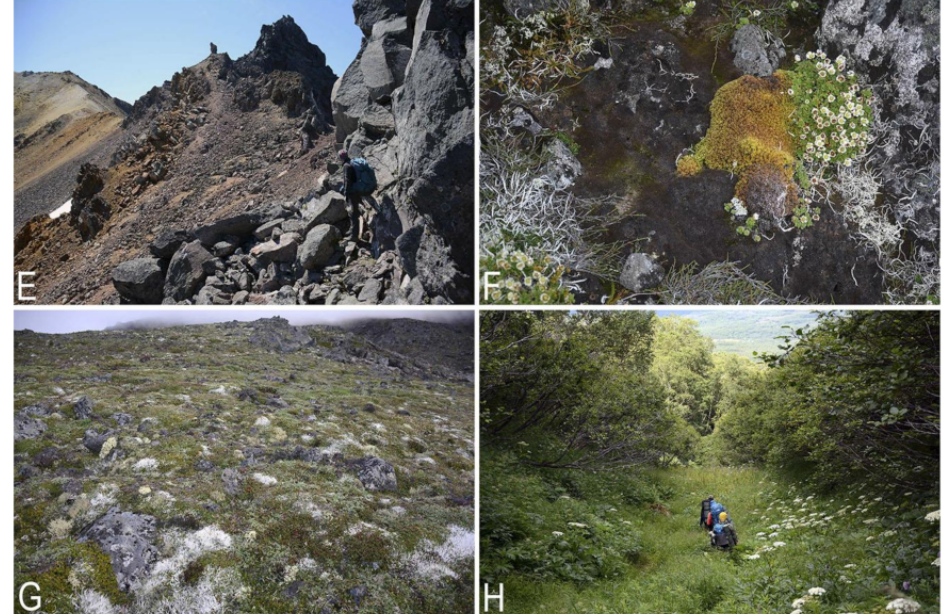
Figure 2. ( A ) S-facing slope of Priyomysh Volcano, dwarf shrub-moss-lichen tundra dominating, Alnus fruticosa clumps are in the foreground, 1048 m a.s.l. ( B ) the foot of NW-facing slope of Khodutka Volcano, dwarf Alnus fruticosa clumps are in the foreground, that changed by dwarf shrub-lichen-moss tundra and pyroclastic deserts above, 1048 m a.s.l. NW-facing slope of Khodutka Volcano: ( C ) dwarf shrub-lichen tundra with rocky outcrops, 1085 m a.s.l.; ( D ) scattered vegetation on pyroclastic deposits, 1256 m a.s.l.; ( E ) north edge of Khodutka Volcano crater crown, 1813 m a.s.l.; ( F ) Gymnomitrion kamchaticum dominating patch, 1654 m a.s.l.; ( G ) dwarf shrub-lichen tundra with rocky outcrops, 1225 m a.s.l. ( H ) Alnus fruticosa vegetation belt near the border of Betula ermanii forest belt on NW-facing slope of Priyomysh Volcano, 430 m a.s.l. (Photo by K.G. Klimova, 2021).